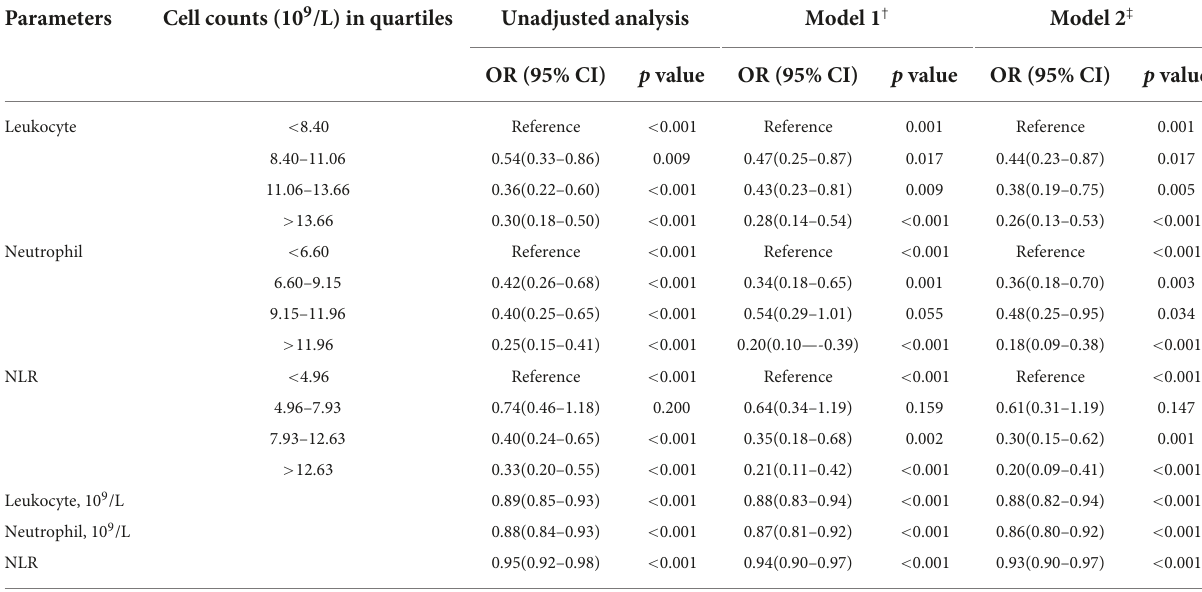
TABLE 3 Unadjusted and adjusted analyses of neutrophil count (x10 9 /L), leukocyte count ( × 10 9 /L), NLR with mRS 0–3 at 90 days. Parameters